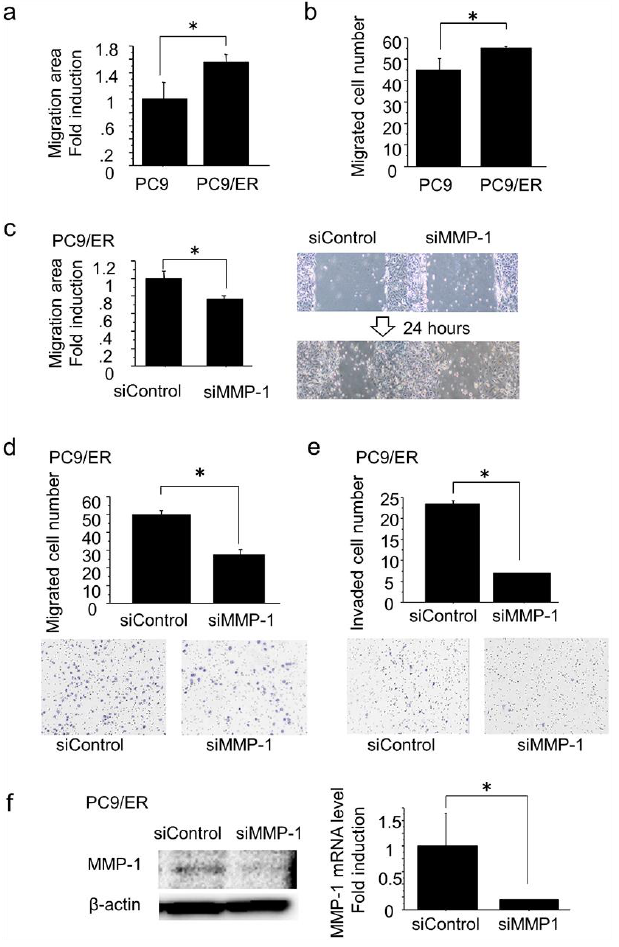
Figure 2. Correlation between MMP-1 expression and migration and invasion in EGFR-TKI–resistant lung adenocarcinoma cells with high expression of MMP-1. ( a , b ) PC9/ER demonstrated significantly higher migration ability for 24 h than PC9/6m. ( a ) Wound healing assay, p = 0.0084. ( b ) Migration assay, p = 0.0314. ( c – e ) Both migration and invasion for 24 h in PC9/ER were significantly inhibited by knockdown of MMP-1 gene using small interference RNA (siRNA) targeting MMP-1 (siMMP-1) treatment for 72 h. Silencer Select Negative Control 1 siRNA (siControl) was used as control. ( c ) Wound healing assay, p = 0.0018. ( d ) Migration assay, p = 0.0004. ( e ) Invasion assay, p = 0.0009. ( f ) The inhibitory effect of siMMP-1 was confirmed by a decrease of protein and mRNA expression of MMP- 1 (mRNA, p = 0.0442). Bars: mean ± standard deviation ( n = 3); * p < 0.05.